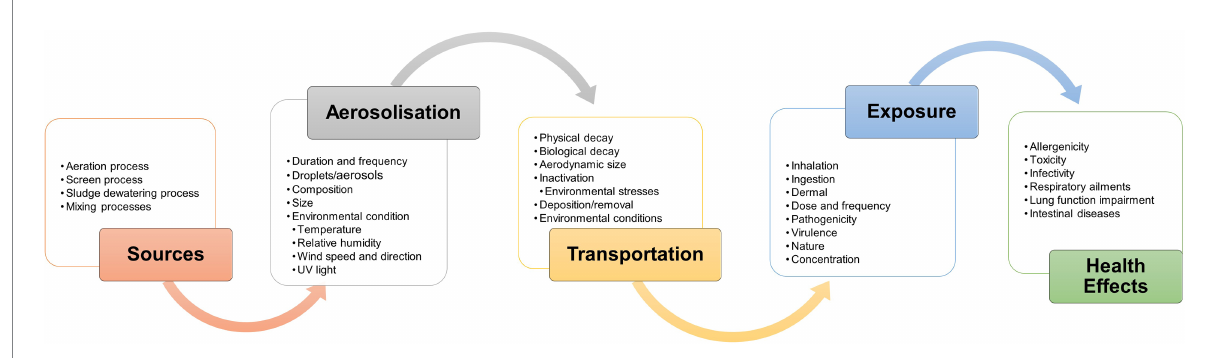
FIGURE 1 Factors influencing dynamics of bioaerosol and potential health effects from emissions at wastewater treatment